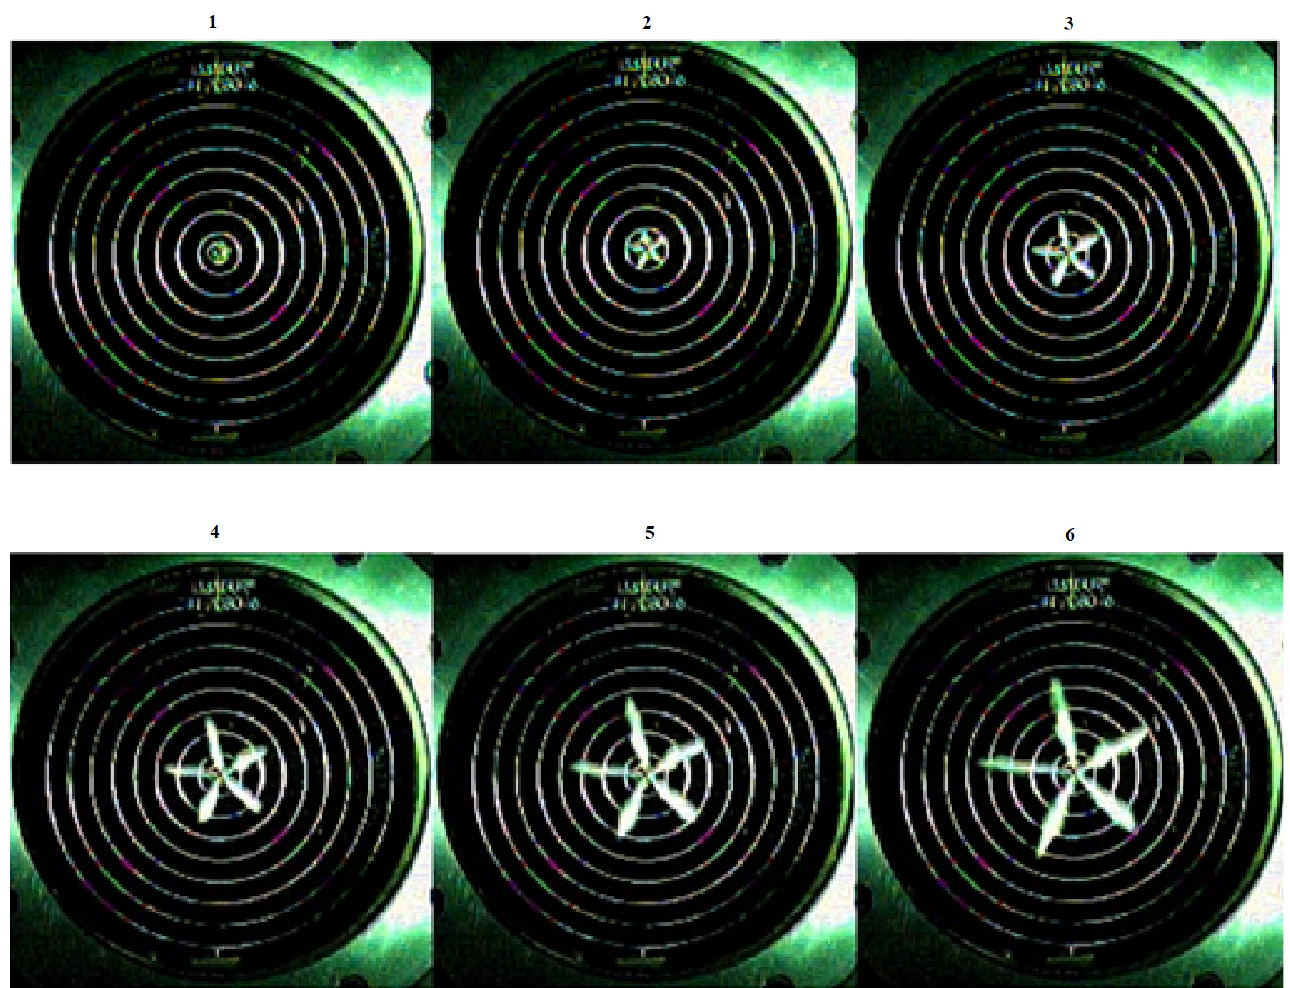
Figure 6. An example of spray evolution registered for ON + ET5 mixture, at a pressure of 125 MPa. The photo numbers indicate successive frames of the recorded film of the injection process.